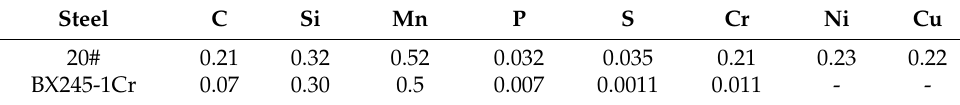
Table 16. The components of the actual products of 20# steel and BX245-1Cr